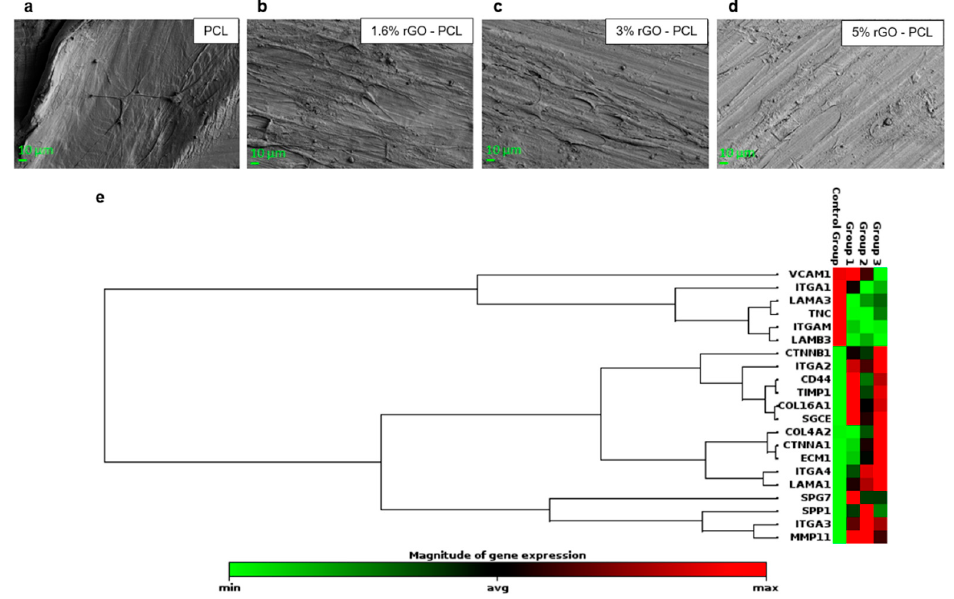
Figure 3. Stem cells adhesion on rGO-PCL surfaces. SEM images of the cells on pure PCL ( a ), 1.6% rGO-PCL ( b ), 3% rGO-PCL ( c ), 5% rGO-PCL at 1 ×K magnification ( d ). ( e ) Expression profile of extracellular matrix and adhesion molecules in HMSCs maintained on rGO-PCL surfaces for 7 days. Heat map reporting under expressed (green) and overexpressed (red) genes in 1.6% rGO-PCL (Group 1), 3% rGO-PCL (Group 2), and 5% rGO-PCL (Group 3) compared with pure PCL (Control Group).